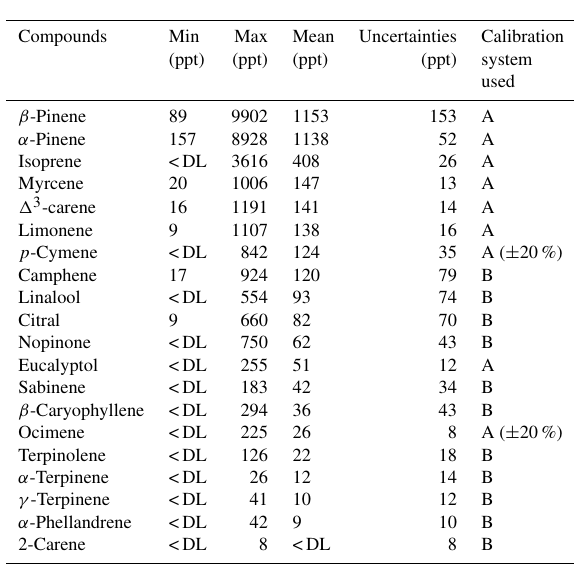
Table 6. Statistics and uncertainties calculated at the mean value for BVOCs measured during the LANDEX field campaign in July 2017. The calibration technique used depended on the compounds and are defined as (A) for the certified NPL gas standard and (B) for the generated